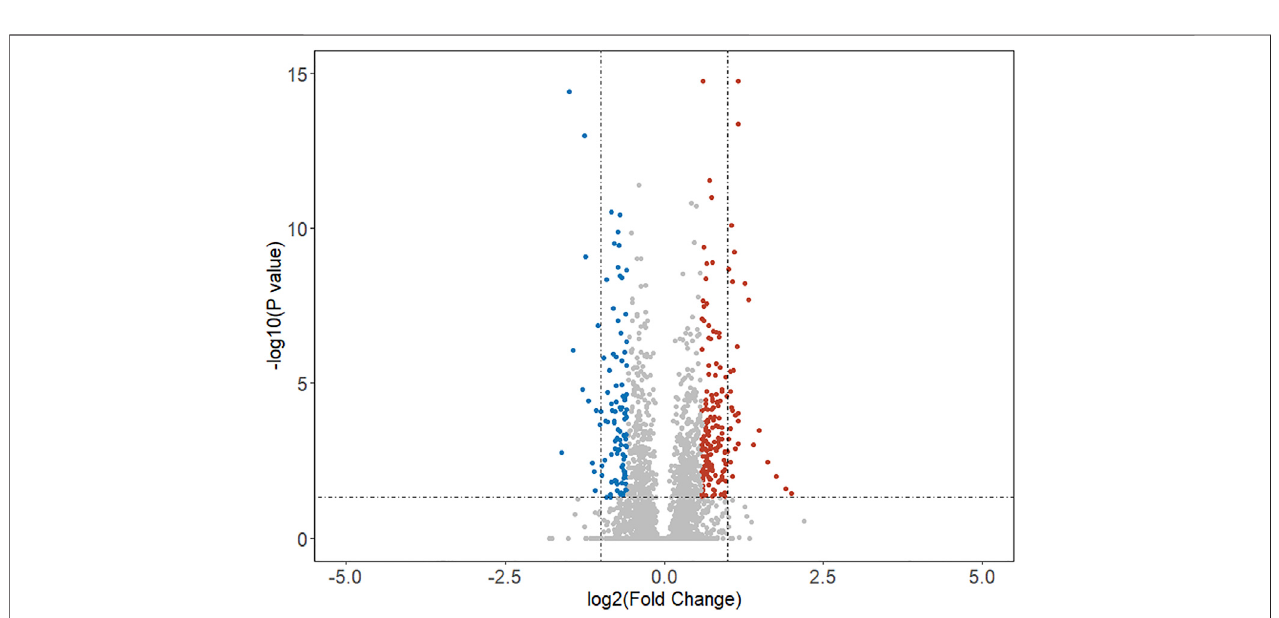
FIGURE1| Volcanomapofdifferentiallyexpressedgenesinmalignantsamplescomparedwithbenignsamples.Thehorizonlinewasthecutoff(adjusted p -value < 0.05) of Student ’ s t test. The vertical line was the cutoff (logFC > 0.58 or logFC < -0.58) of the fold change method. The blue and red dots indicated the downregulated and upregulated genes,